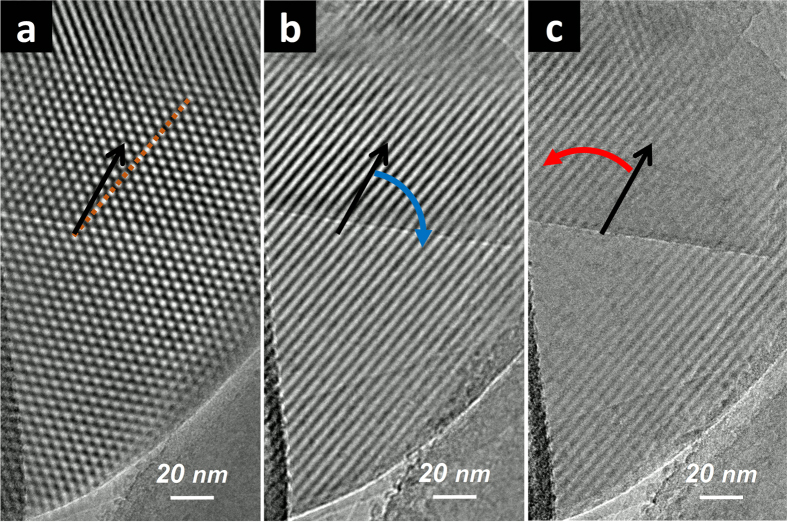
Evolution of mesoscale hexagonal Moiré patterns from BNNS vdW superstructures to parallel line fringes by tilting: (a) 0°; (b) + 4°; (c) −1°. The black-colored arrow indicates the tilting axis that slightly deviates from [110] (orange-colored dash line). The red and blue arrows indicate tilting toward θ > 0 and θ < 0 directions, respectively.